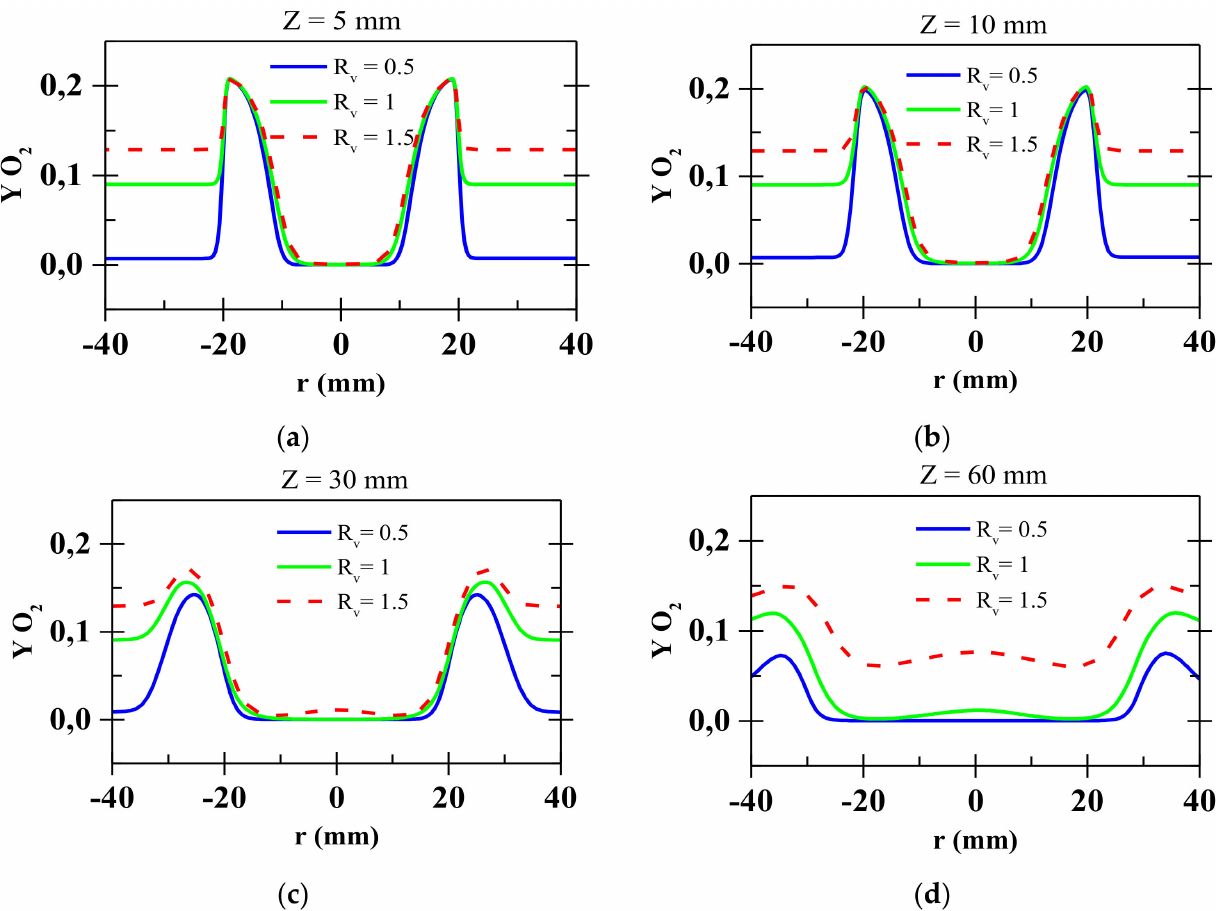
Figure 12. Computed radial profiles of oxygen mass fractions for different velocity ratios and at four heights; ( a ) Z = 5 mm; ( b ) Z = 10 mm; ( c ) Z = 30 mm; ( d ) Z = 60